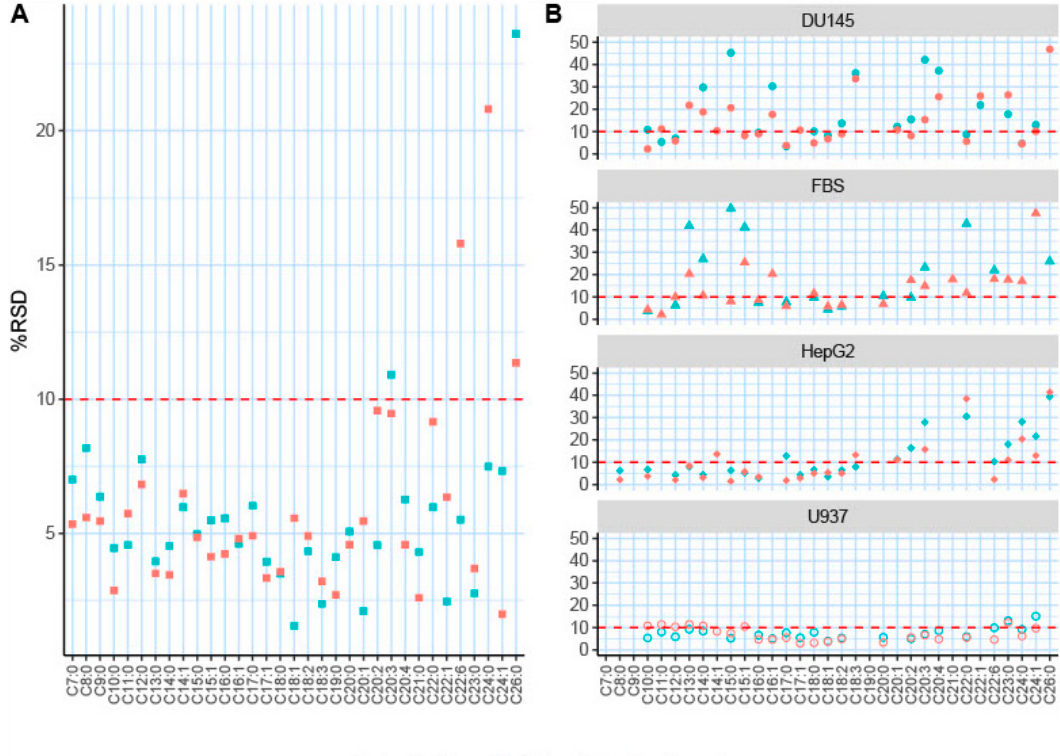
Figure 4. The %RSD comparison for fatty acid derivatization methods. Plot comparison of all %RSD values for each derivatization technique and each biological matrix. The red line across the plot at 15 represents a commonly accepted cutoff for highly reproducible metabolomics data. ( A ) The %RSD values for the 33 fatty acid standards utilized to validate the method. ( B ) The reproducibility of each fatty acid in the following biological matrices: human prostate cancer cell line DU145; fetal bovine serum (FBS); human liver cancer cell line HepG2; and U937, a human myeloid leukemia cell line.